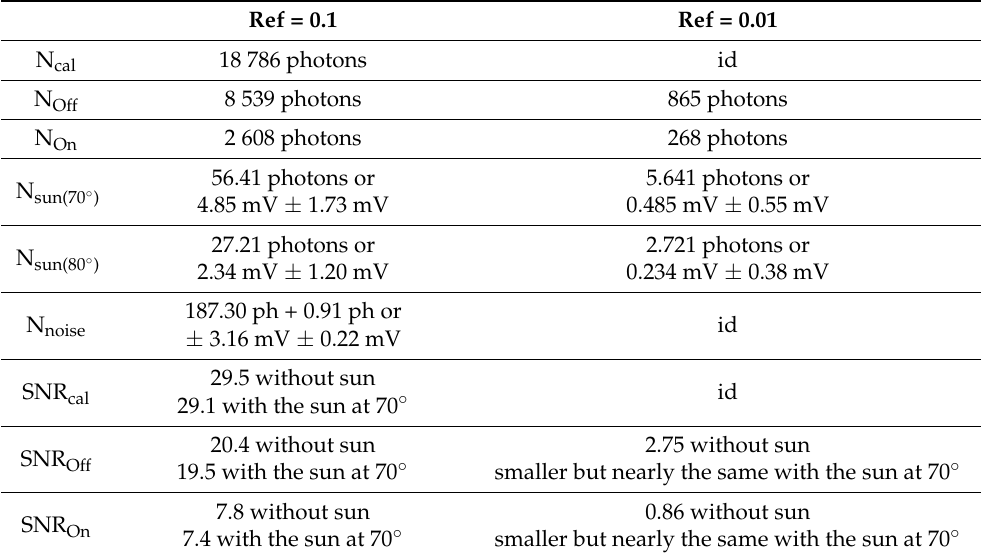
Table 5. For two ground reflectance values: the number of photons in the laser pulses (calibration, Off and On), the number per samples of photons in the solar flux and their contribution in mV to both the signal offset and the additional variability (for a sun zenith angle of 70 ◦ and 80 ◦ ), the electronic noise (both for the amplified part as signal or current noise and for the differently amplified part or voltage noise) expressed in photons per sample and by its contribution in mV to the bias and dispersion, and finally, the 3 SNRs of the laser peak energy: calibration, Off and On (with and without solar flux). Ref = 0.1 Ref = 0.01 N cal 18 786 photons id 865